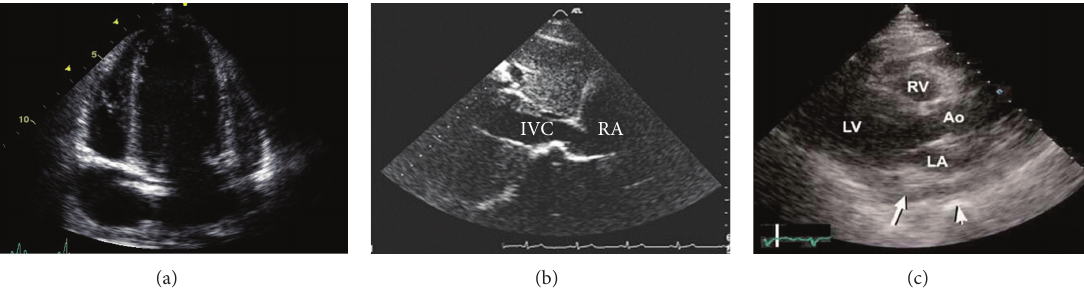
Figure 2: Echocardiography showing septal bouncing (a), dilation of IVC (b), pericardial effusion, and calcification (c).